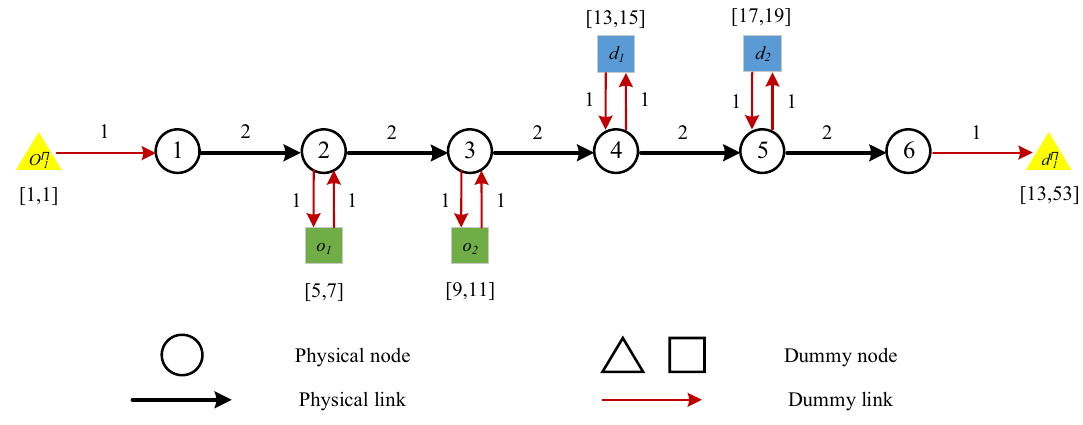
Fig. 7 Network layout and time-window settings for the basic